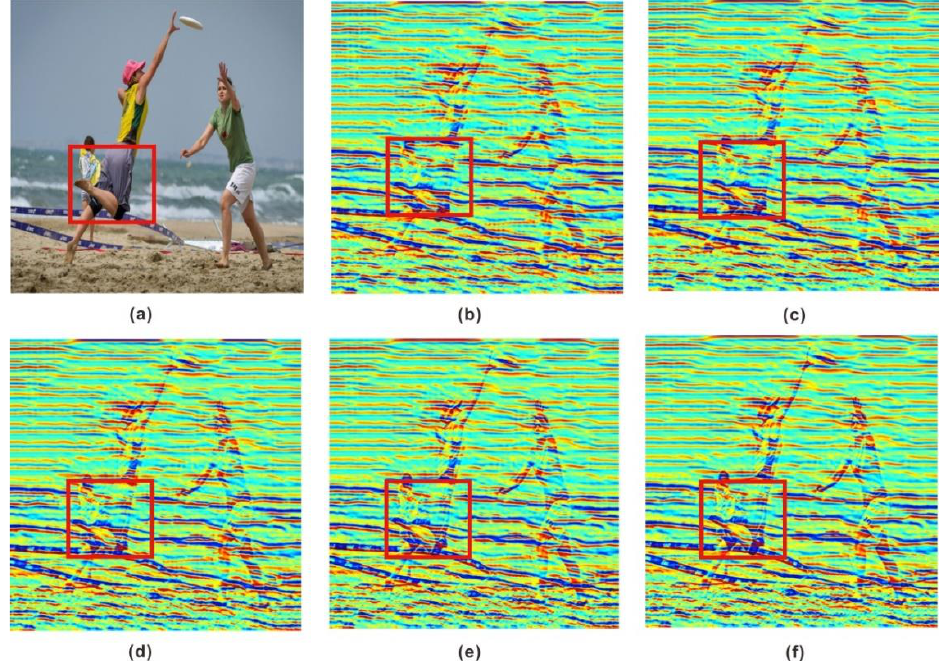
Figure 10. Second training results of revision network. Visually, the overall color is brighter than before, and the beach position, shape of the waves and details of the woman’s legs are further highlighted. ( a ) Content. ( b ) Content weight = 1.0; style weight = 3.0; the woman’s leg muscle contour is blurred. ( c ) Content weight = 1.0; style weight = 2.0; the woman’s leg detail lines are too thick to finely restore the original leg features. ( d ) Content weight = 1.0; style weight = 1.0; the contour is clear and the overall composition is bright. ( e ) Content weight = 2.0; style weight = 1.0; the effect is equivalent to ( d ). ( f ) Content weight = 3.0; style weight = 1.0; the effect is equivalent to ( e ).